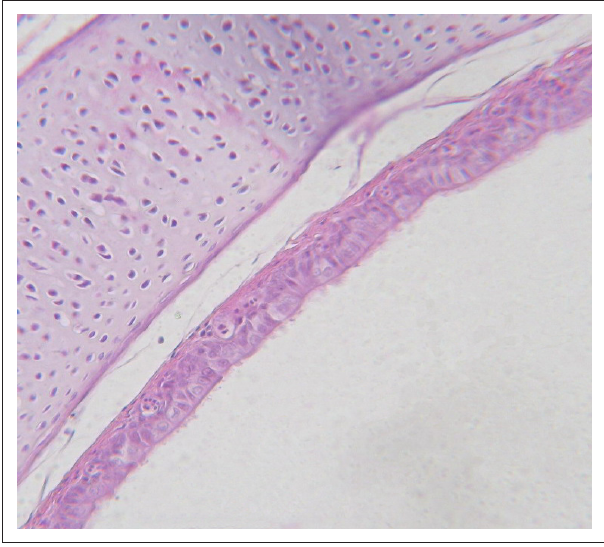
FIGURE 1 : Trachea – desquamation and deciliation of epithelial cells, 2 days post-inoculation.